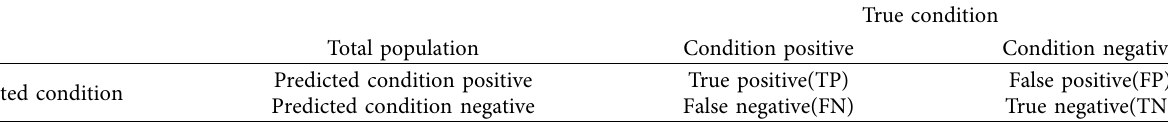
Figure 3: Averaged odor lock sensor data for the representative batch. Table 3: Calculation of performance metrics by a confusion